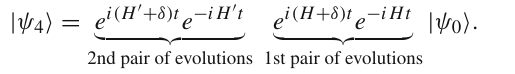
the dashed line is − log [LE]. Right: Logarithmic plot for early time behaviour of higher LE (blue, green, gray) and complexity (red, cyan, yellow) and slope matching (black dotted